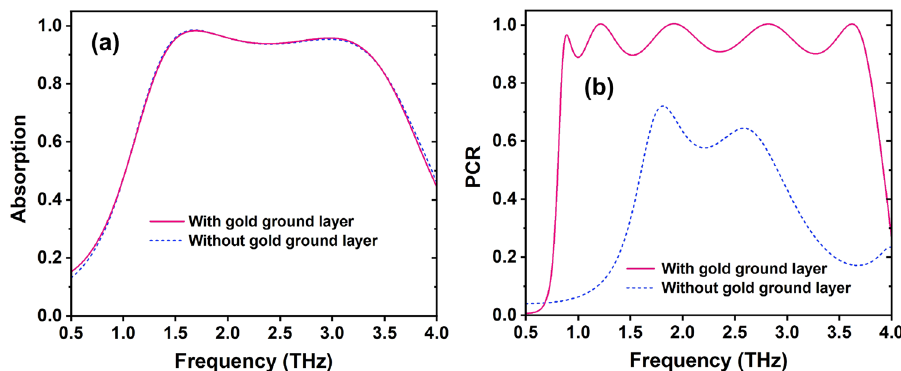
Figure 5. Effect of the continuous gold ground layer on the performance of the proposed RMS for ( a ) ABS and ( b ) PC modes.